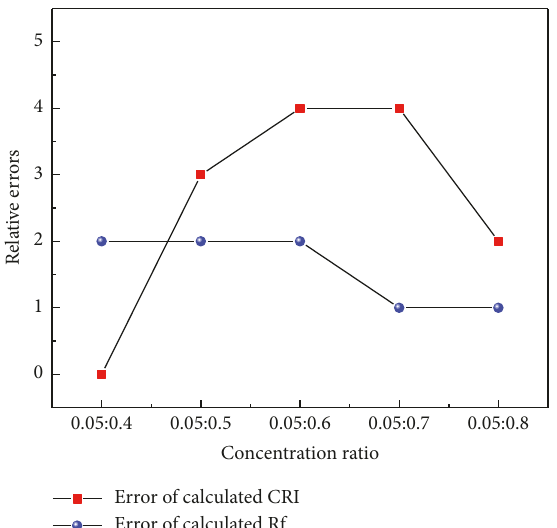
Figure 15: Errors of R and CRI made by experiment and simulation at different mass ratios of green and red laminated phosphor film layers. f